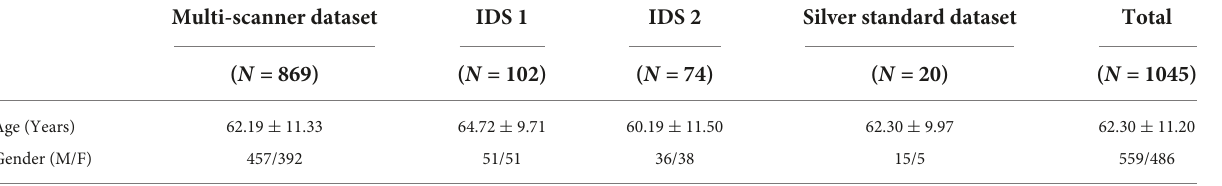
TABLE 1 Demographic features of the in-house datasets.